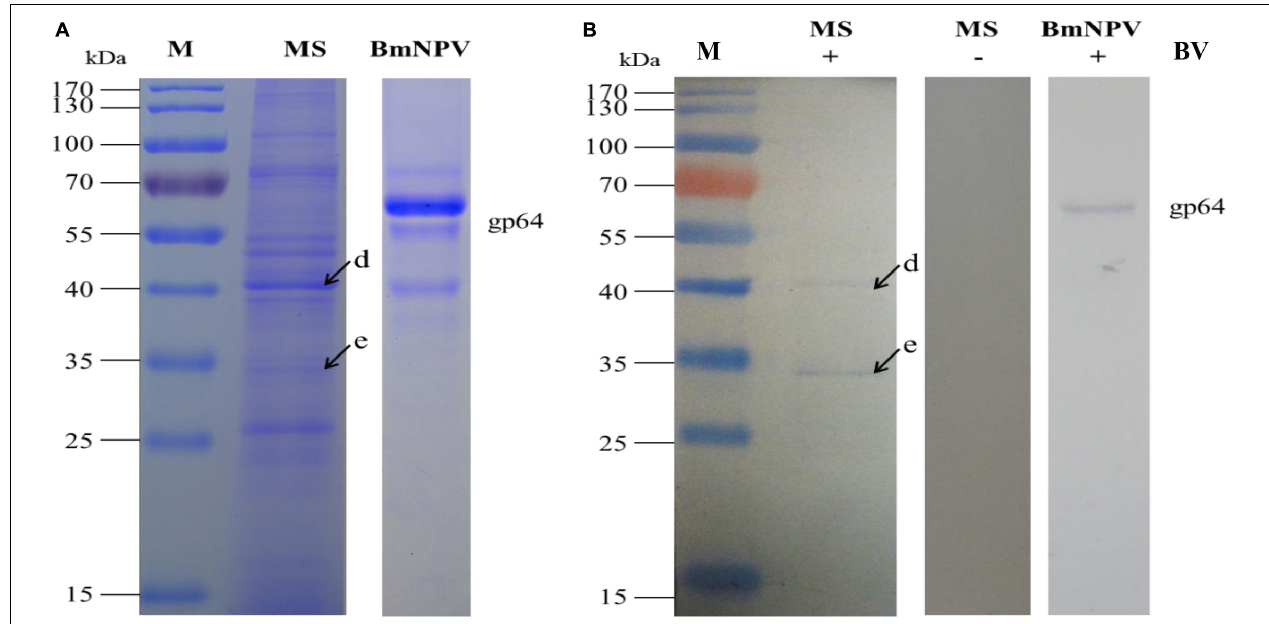
FIGURE 4 | Identification of virus-binding in the microsomal proteins fraction of the P50 midgut on SDS-PAGE. (A) Separation of Bombyx mori midgut microsomes (MS) and BmNPV budded viruses (BVs) proteins by SDS-PAGE. (B) Virus overlay binding experiment. Microsomes protein blots, overlaid with (MS + BV) and without